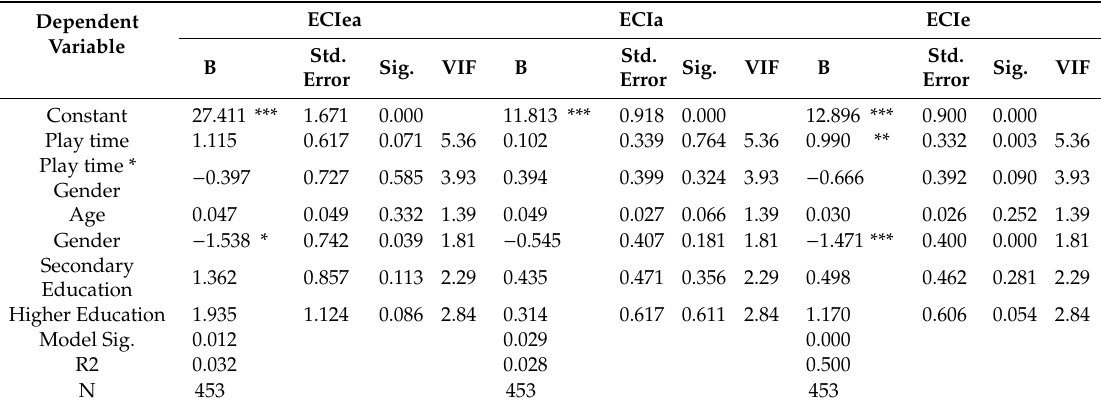
Table 5. The relationship between the e ff ectiveness and authenticity components of the emotional creativity inventory (ECIea, ECIe, ECIa), and the frequency of playing computer games moderated for gender. Results of the multivariate regression